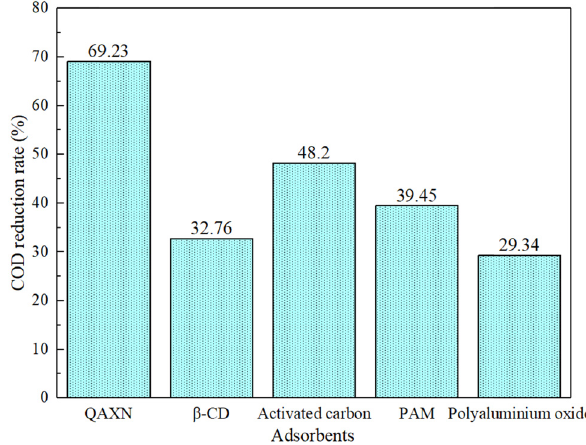
Figure 8: The in fl uence of di ff erent treatment agents on the COD value of the waste water - based drilling fl uid